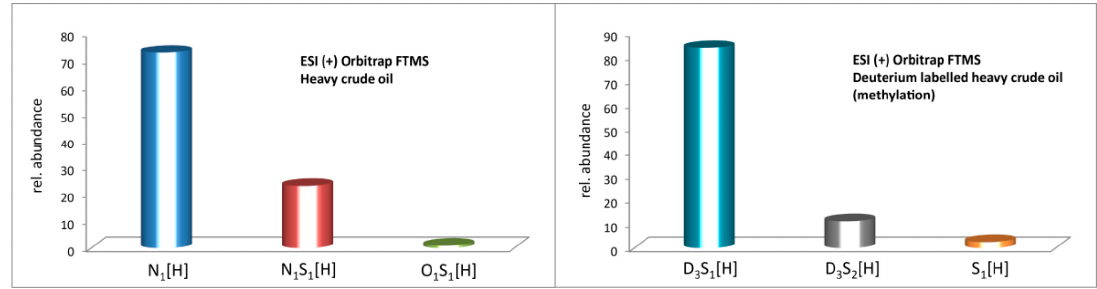
Figure 4. Class distribution for heavy crude oil from direct analysis ( left ) and heavy crude oil after deuterium labelled methylation ( right ).